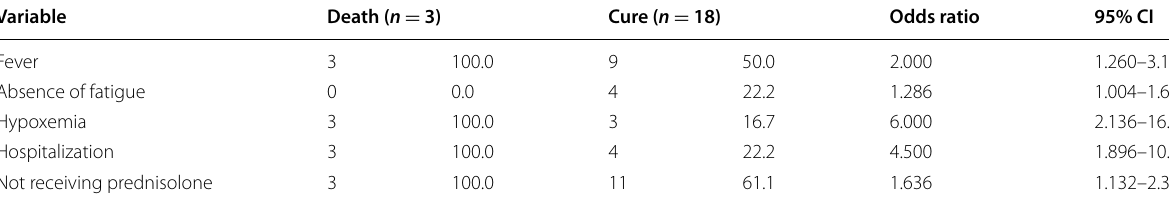
Table 6 Odds ratio for mortality among COVID-19 PH cases